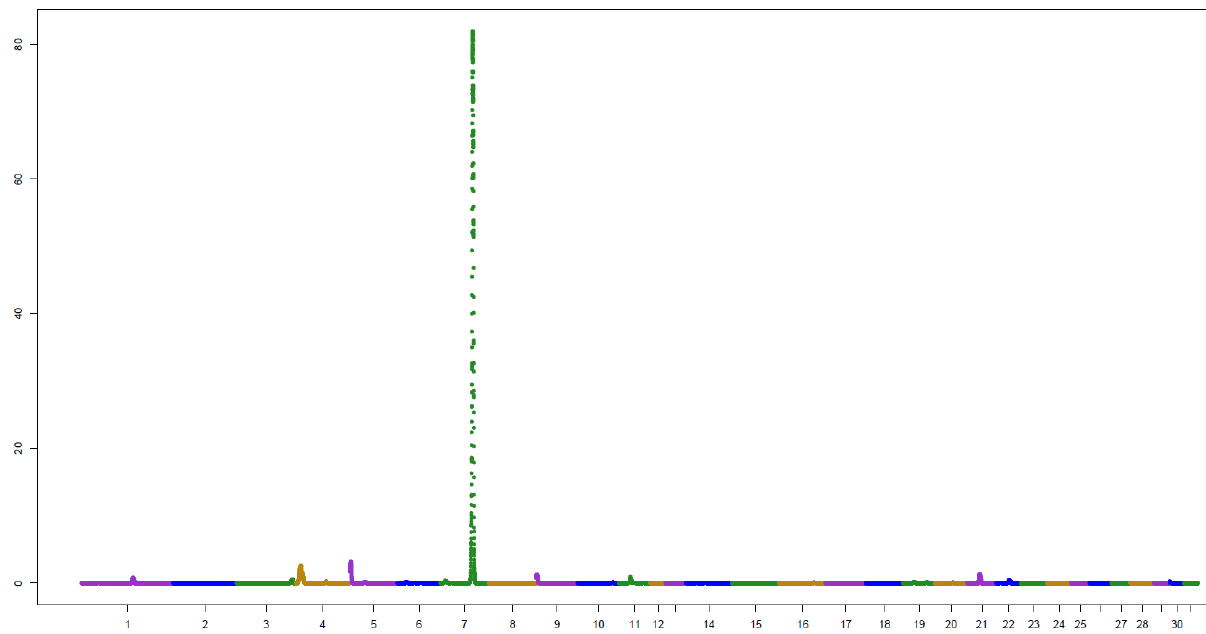
Table 2. Genomic windows and percentage of additive genetic variance (Va%) in the four hair whorl phenotypes explained by each window. Phenotype